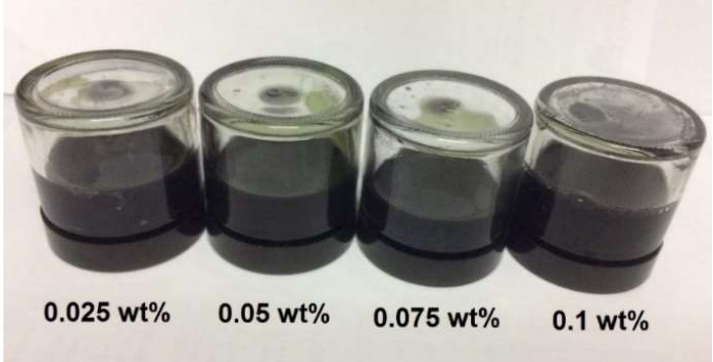
Figure 1. Photograph image of prepared sample of GNP nanofluid after three months.